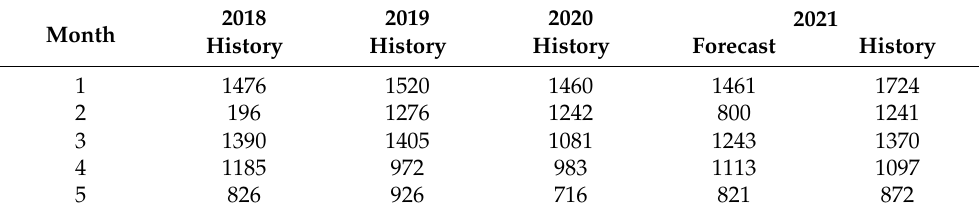
Figure 8. Spatial distribution of executed and predicted emergency SOs throughout the biggest city in the state of Sergipe, Aracaju, in the first 5 months of 2021. Table 1. Total number of emergency SO in the past 3 years for the city of